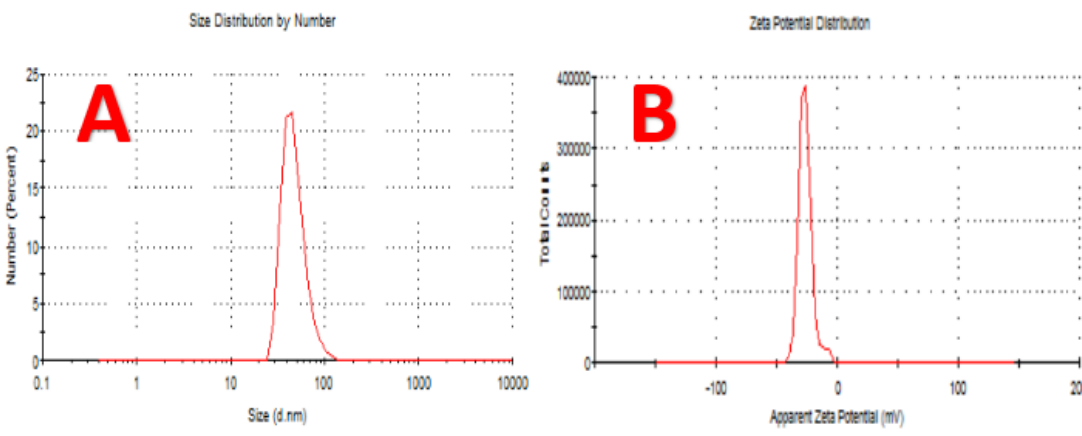
Figure 8. ( A ) The particle size distribution of biotransformation CuNPs. ( B ) Zeta potential of